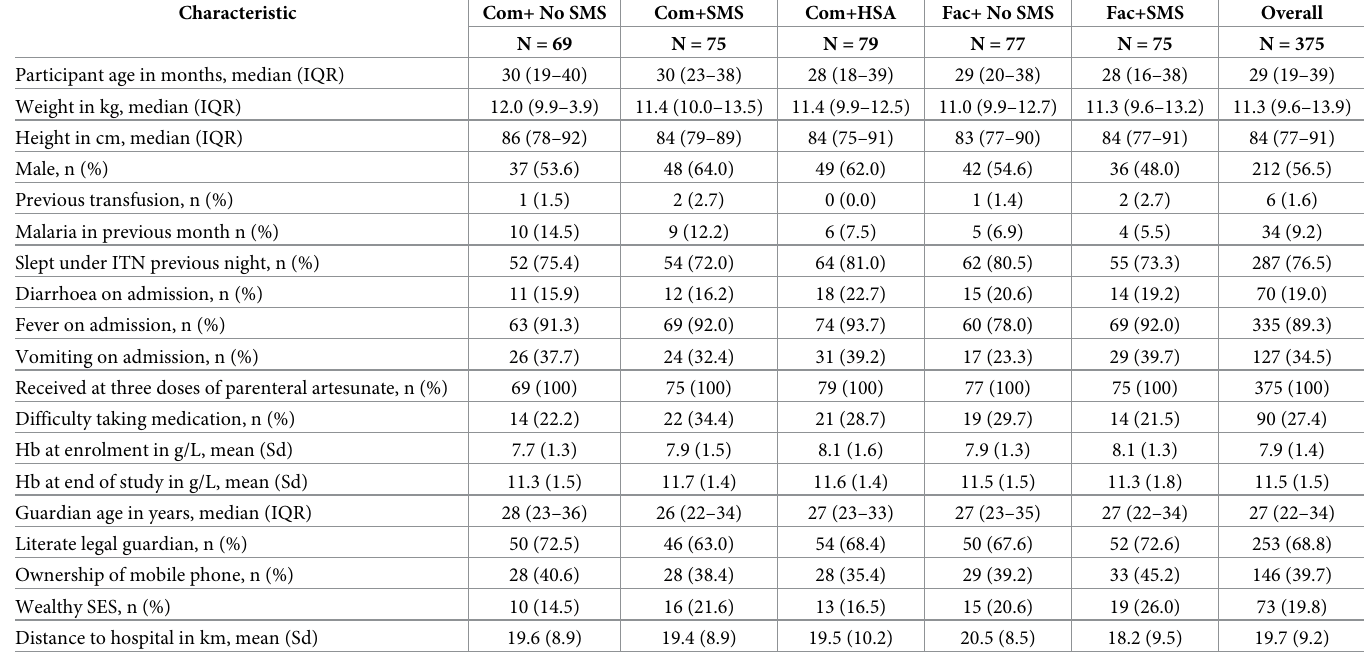
Table 2. Baseline characteristics of trial participants.